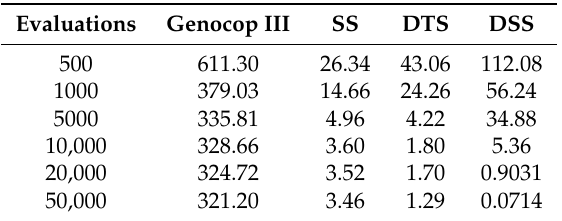
Table 8. The comparison results of DSS and other